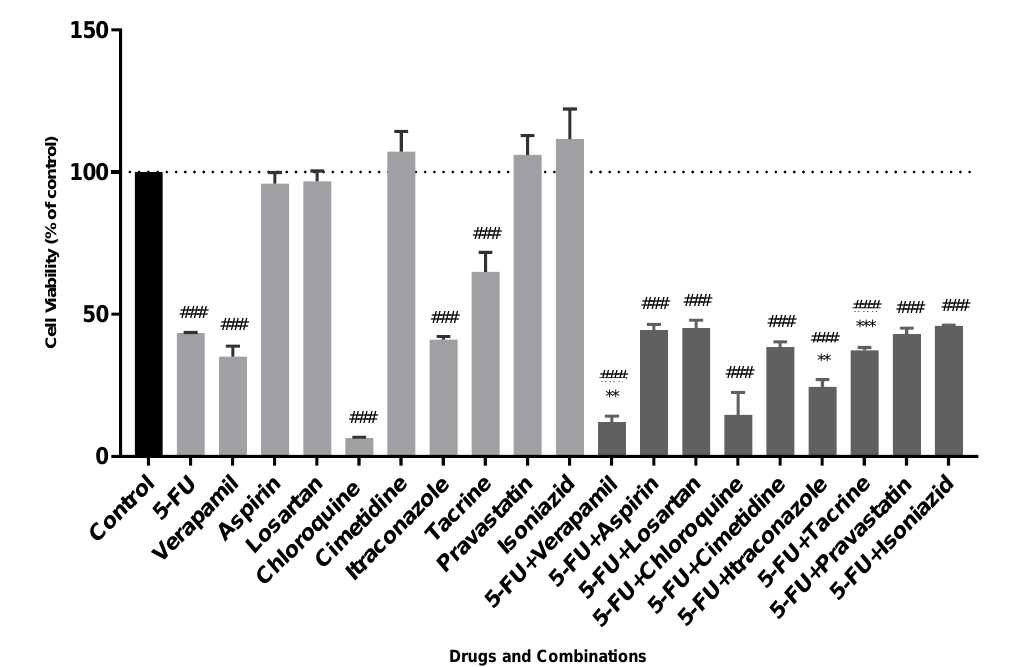
Figure 3. Cell viability values of single drugs and drug combinations in MCF-7 cells. All the compounds were added to cells in sextuplicates. The results (mean ± SEM) are presented as a percentage of the control (100%) of four independent experiments. ### p < 0.001 vs. control; ** p < 0.01 and *** p < 0.001 vs. the more effective drug of the combination. Reproduced from [7].